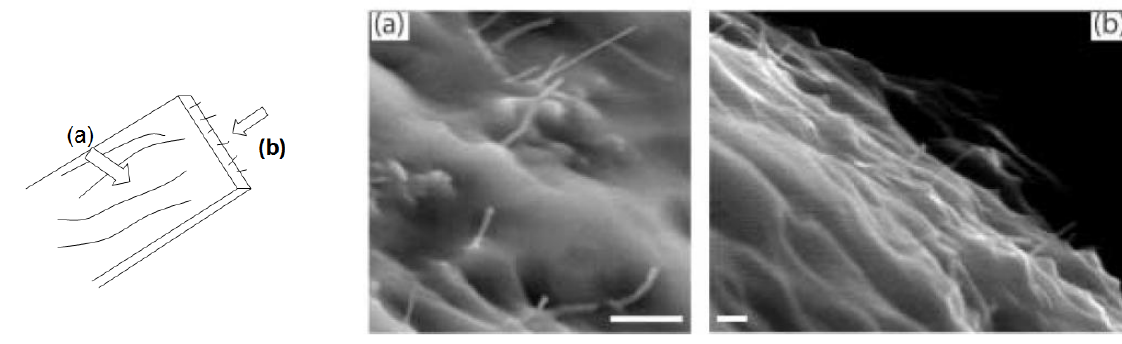
Figure 3. Sketch of a plane strip of nematic elastomer with embedded aligned CNTs. The arrows indicate two planes of freeze-fracture, shown in electron microscopy images of 0.02% CNT sample: ( a ) in the plane parallel to the nematic director and the nanotube alignment axis, viewed from the top; ( b ) in the plane perpendicular to this axis, viewed edge-on. The scale bar in both images is 0.5